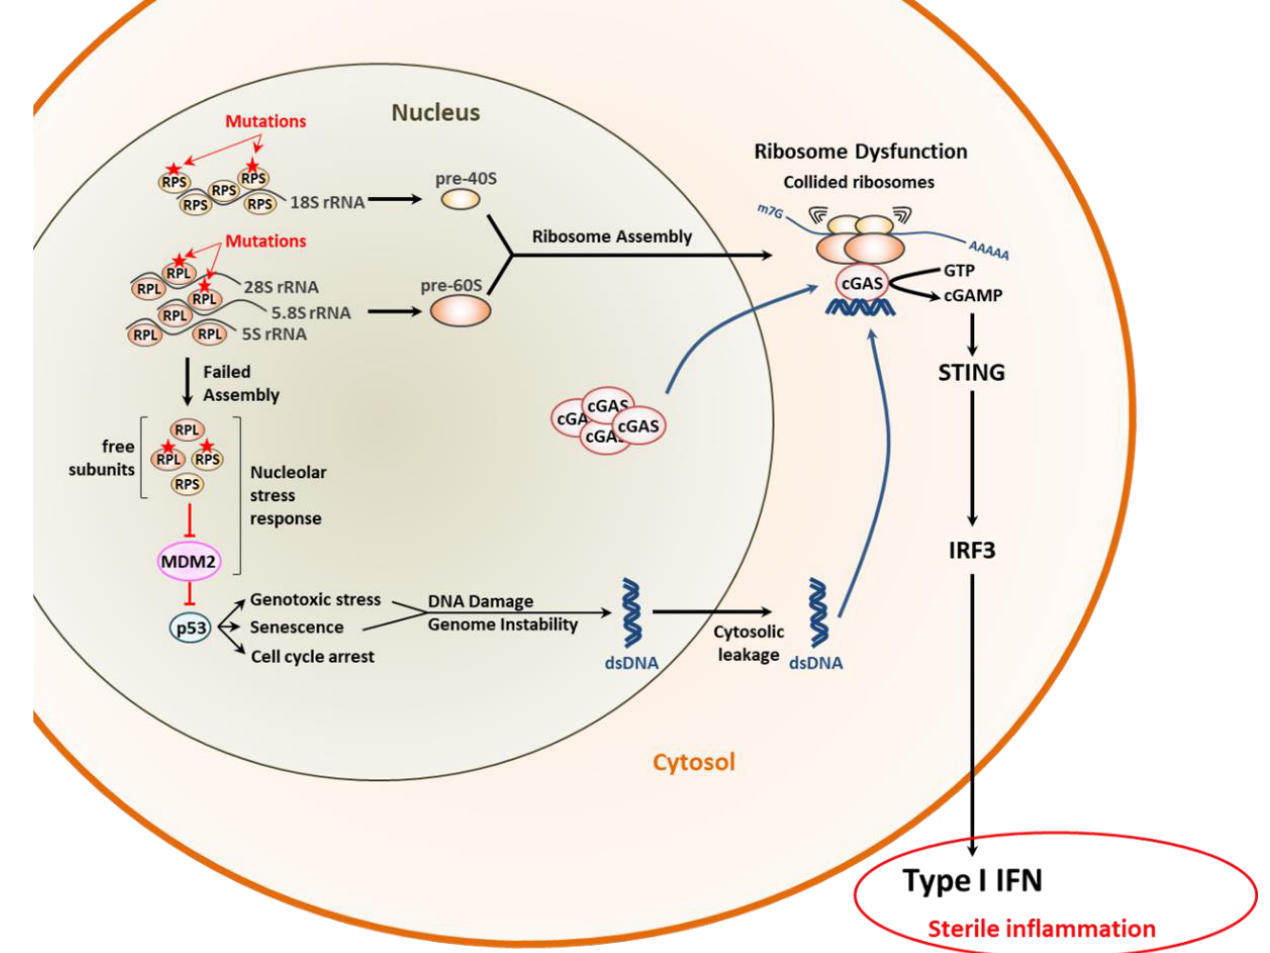
Figure 3. Molecular pathogenesis of ribosomopathies and their potential inflammatory consequences. The failure of mutant ribosomal proteins of the small 40S (RPS) and/or large 60S (RPL) ribosomal subunits to assemble into ribosomes induces the nucleolar stress response leading to p53 stabilization via persistent inactivation of the MDM2 E3 ubiquitin ligase. This, in turn, results in genome instability and subsequent leakage of double-stranded (ds)DNA into the cytosol. Cytoplasmic dsDNA is then sensed by the cyclic GMP-AMP synthase (cGAS) which promotes a type I IFN response via the STING/IRF3 signaling pathway, as indicated. The recruitment of cGAS in the cytosol is itself facilitated by defective and collided